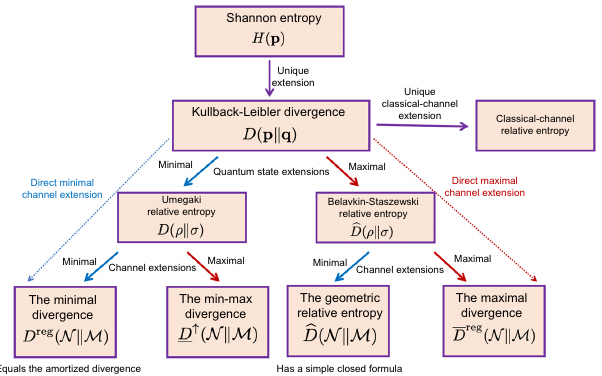
FIG. 1. A summary of all optimal extensions of the Shannon entropy. The red arrows represent maximal extensions and the blue arrows represent minimal extensions. The Kullback-Leibler divergence is the only classical relative entropy that reduces to the log of the dimension minus the Shannon entropy when the second argument is a uniform distribution (in Ref. [4], a one- to-one correspondence between classical entropies and classical relative entropies has been proven). Regularization is assumed in all extensions. The channel relative entropy D reg ( N (cid:4) M ) equals both the amortized divergence and the regularized min- imal channel extension D reg ( N (cid:4) M ) . It is the smallest of all the channel relative entropies that reduce to the Kullback-Leibler divergence on classical states, while the maximal divergence D reg ( N (cid:4) M ) is the largest one. The blue and red dashed arrows indicate that the minimal and maximal channel extensions can be obtained directly from the Kullback-Leibler divergence using the extension techniques introduced in this